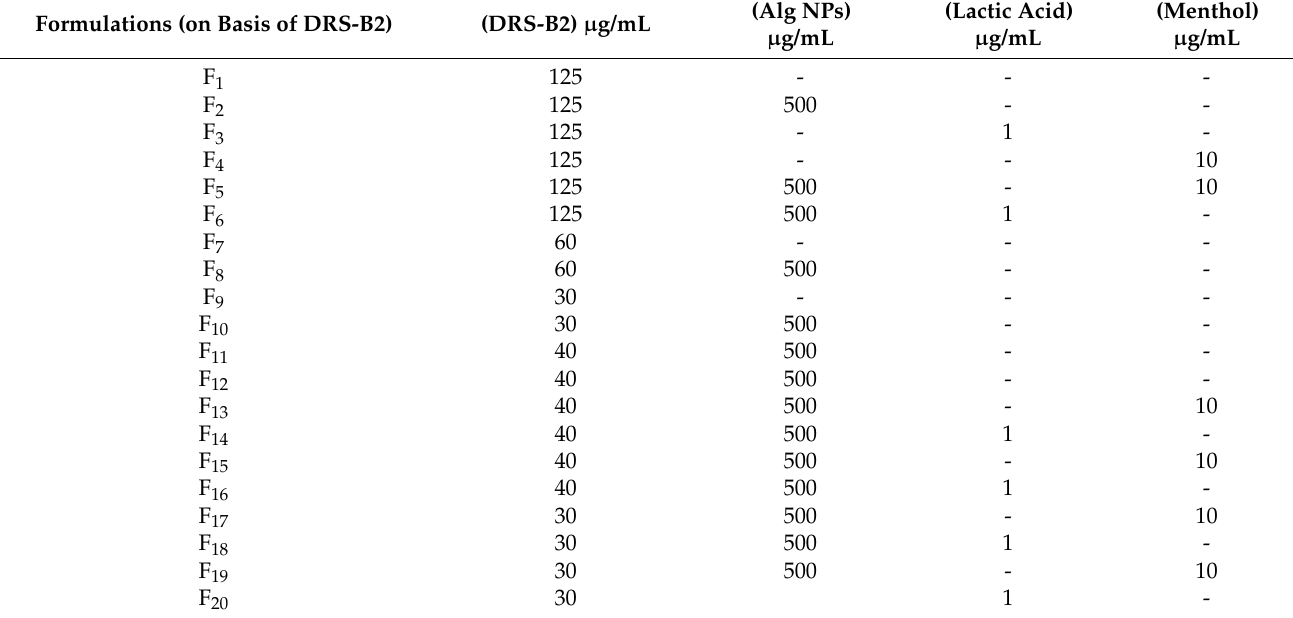
Table 1. Formulations of Alg NPs + DRS-B2 supplemented with small molecules such as menthol or lactic